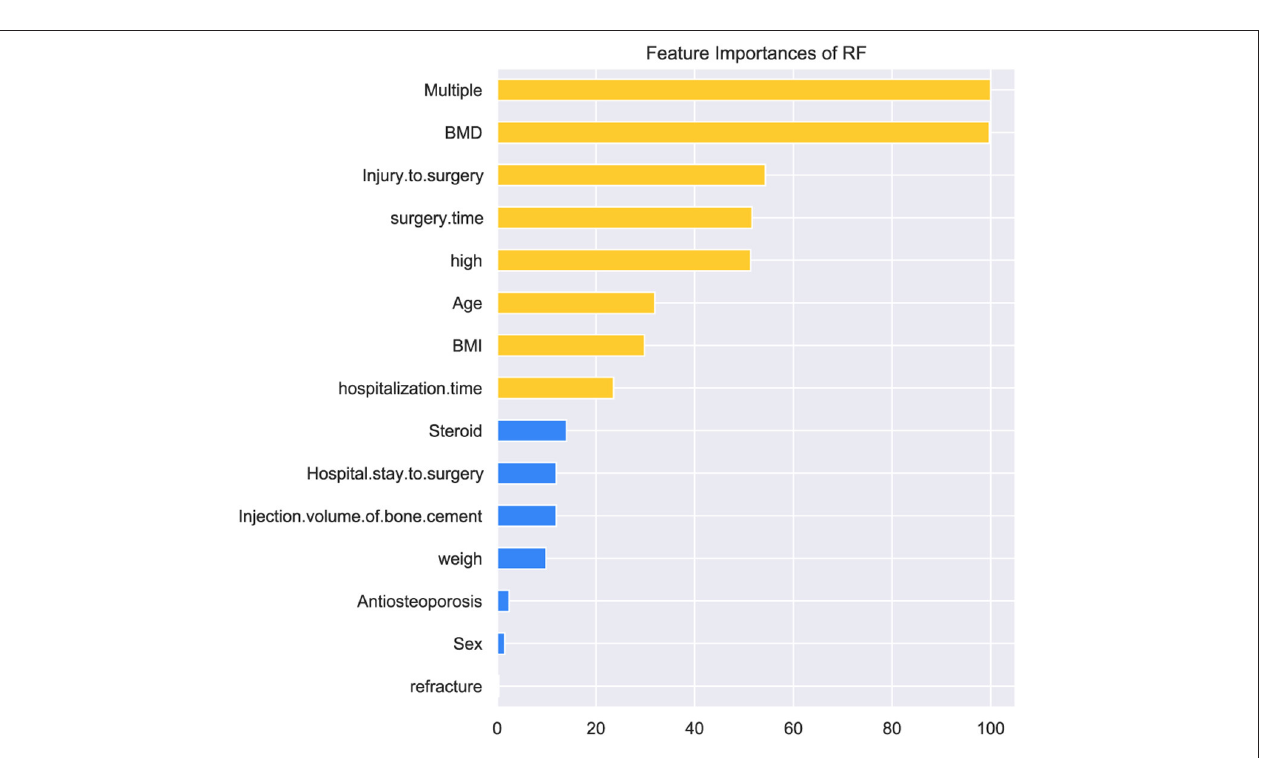
FIGURE 3 | Patient clinical feature importance of Random